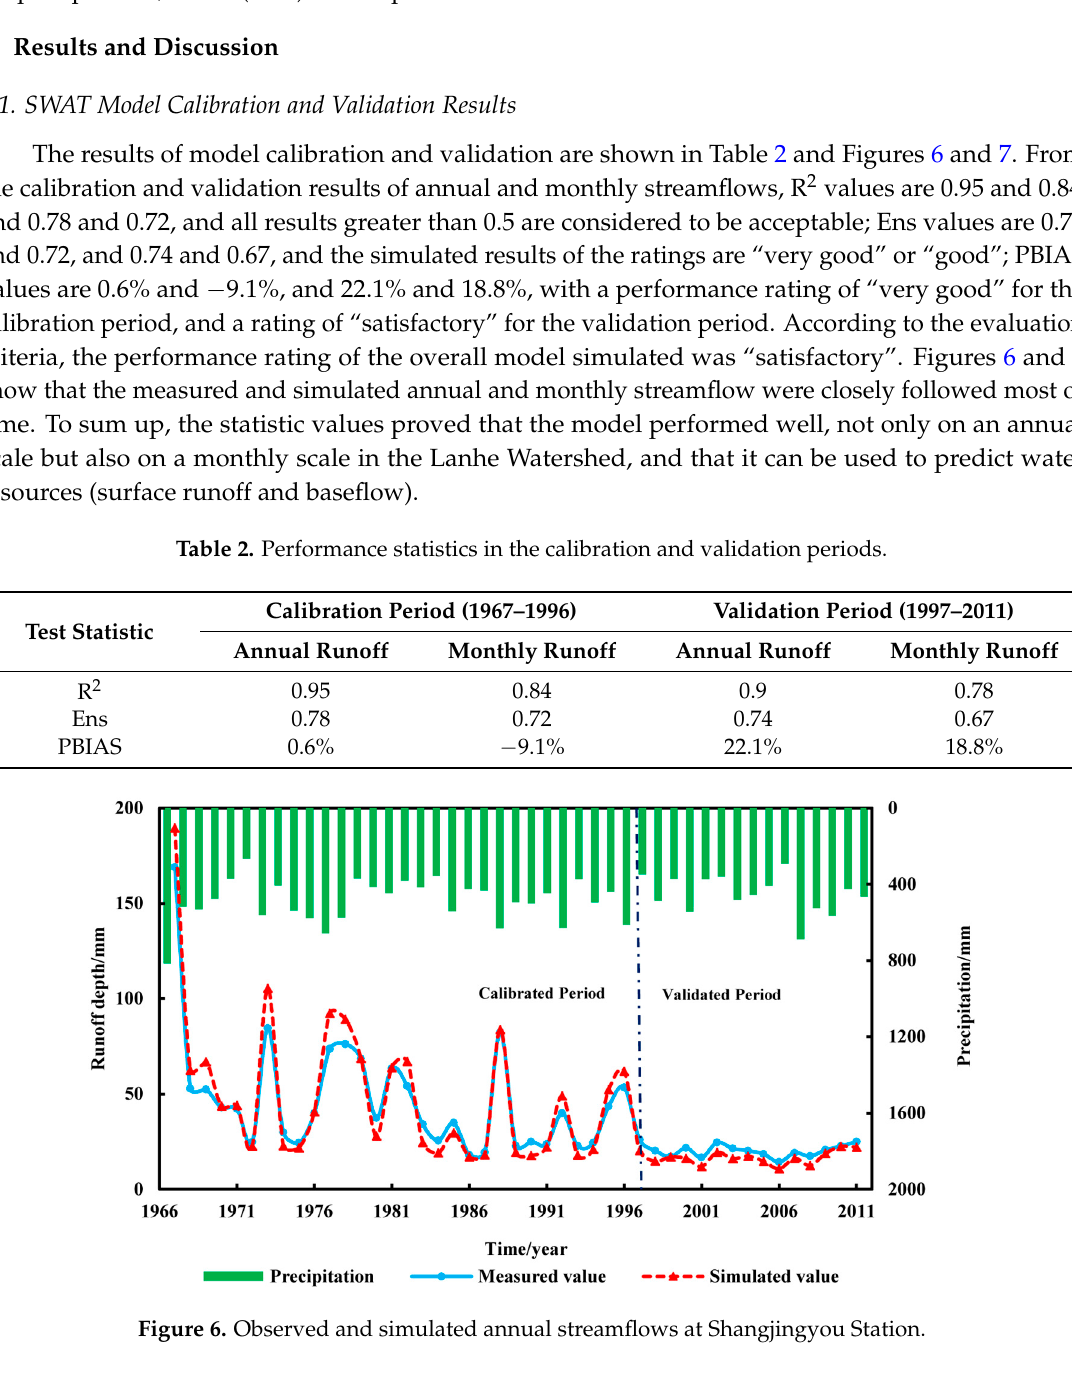
Figure 7. Observed and simulated monthly average streamflows at Shangjingyou Station. From the calibration and validation results, the optimal parameters of calibration and validation are listed in Table 3.